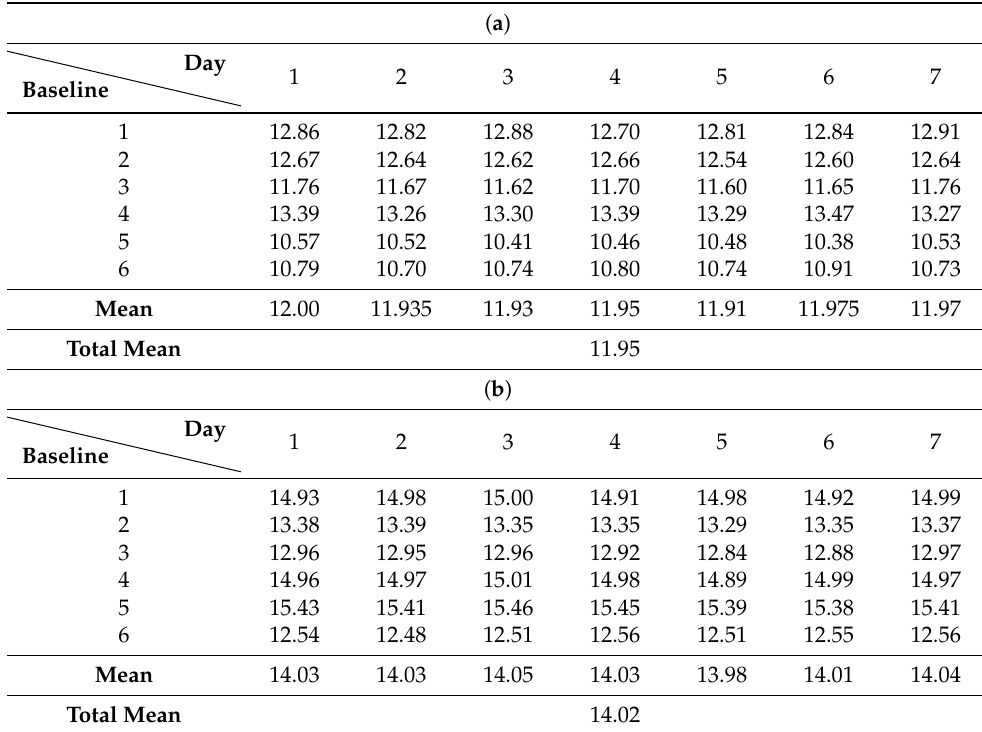
Table 3. The RMSE between IGS ZTD and: ( a ) Estimated ZTD with δ ZWD and ( b ) Estimated ZTD without δ ZWD